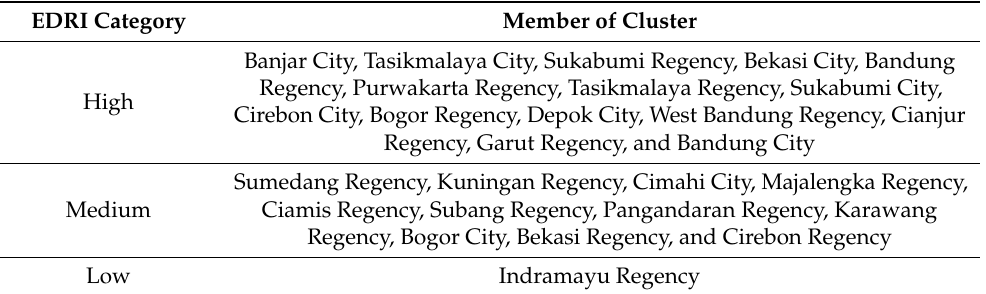
Table 3. The results of clustering subregions based on EDRI